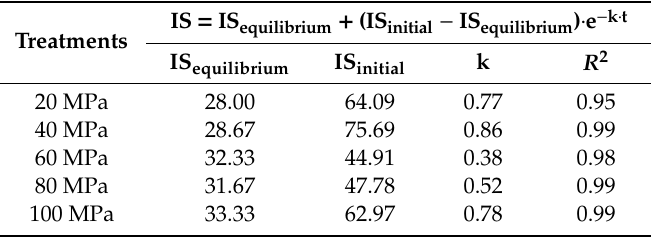
Figure 4. Effect of high-pressure homogenization on the sedimentation index (IS) of lily pulp (20–100 MPa) during 30 days of storage at 25 °C: the dashed curves are the models described in Table 1. Table 1. Mathematical modeling of the sedimentation index (IS) of the homogenized lily pulp during 30 days of storage at 25 °C.